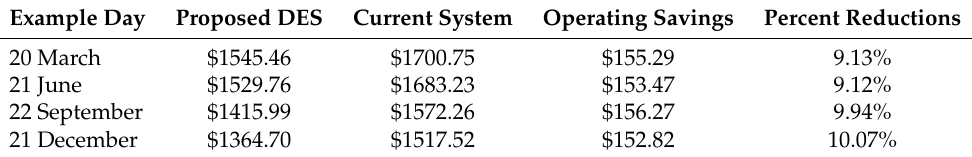
Table 6. Comparison of average operating